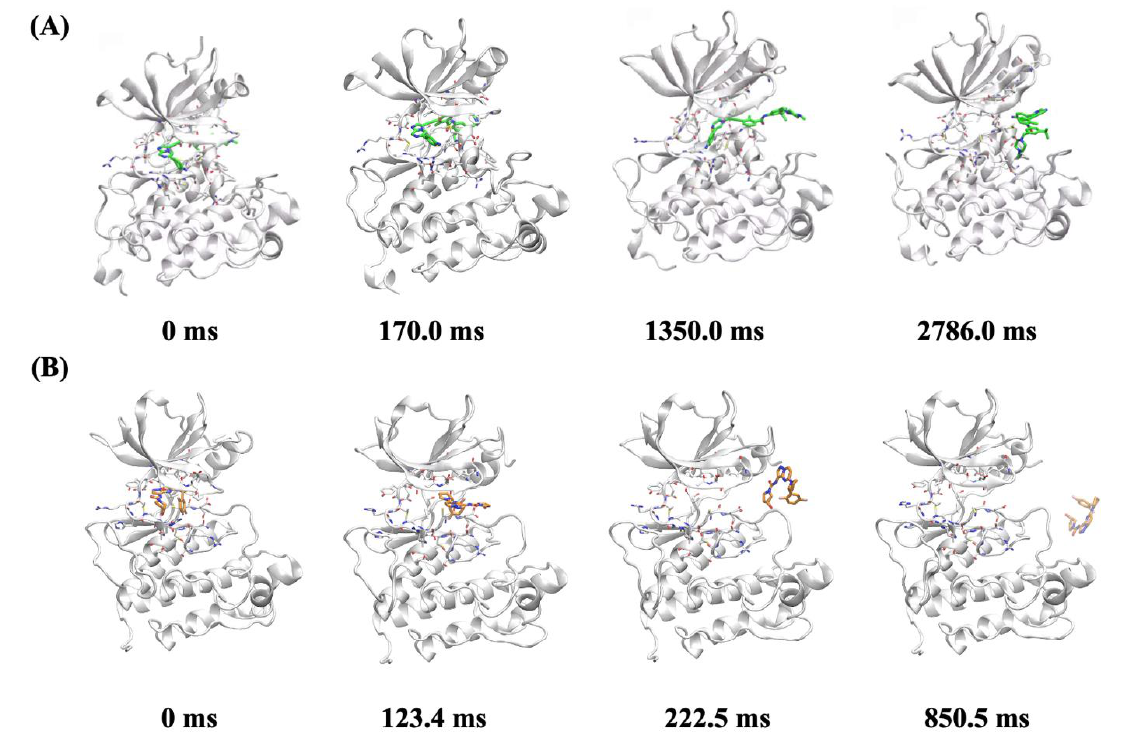
Figure 6. The representative structures for the unbinding process of ( A ) JND4135 from TRKA-G667C; and ( B ) larotrectinib from TRKA-G667C.